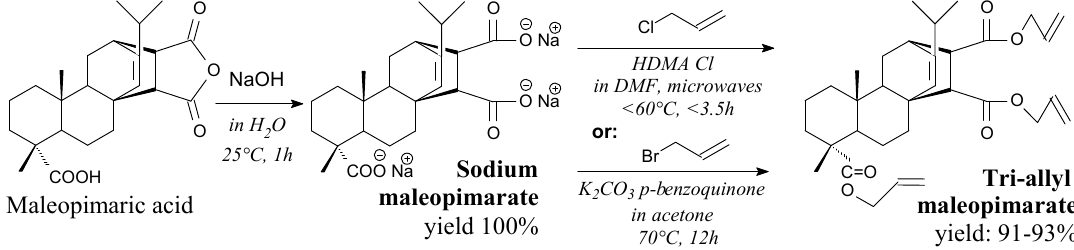
Scheme 18. Synthesis of triallyl maleopimarate.